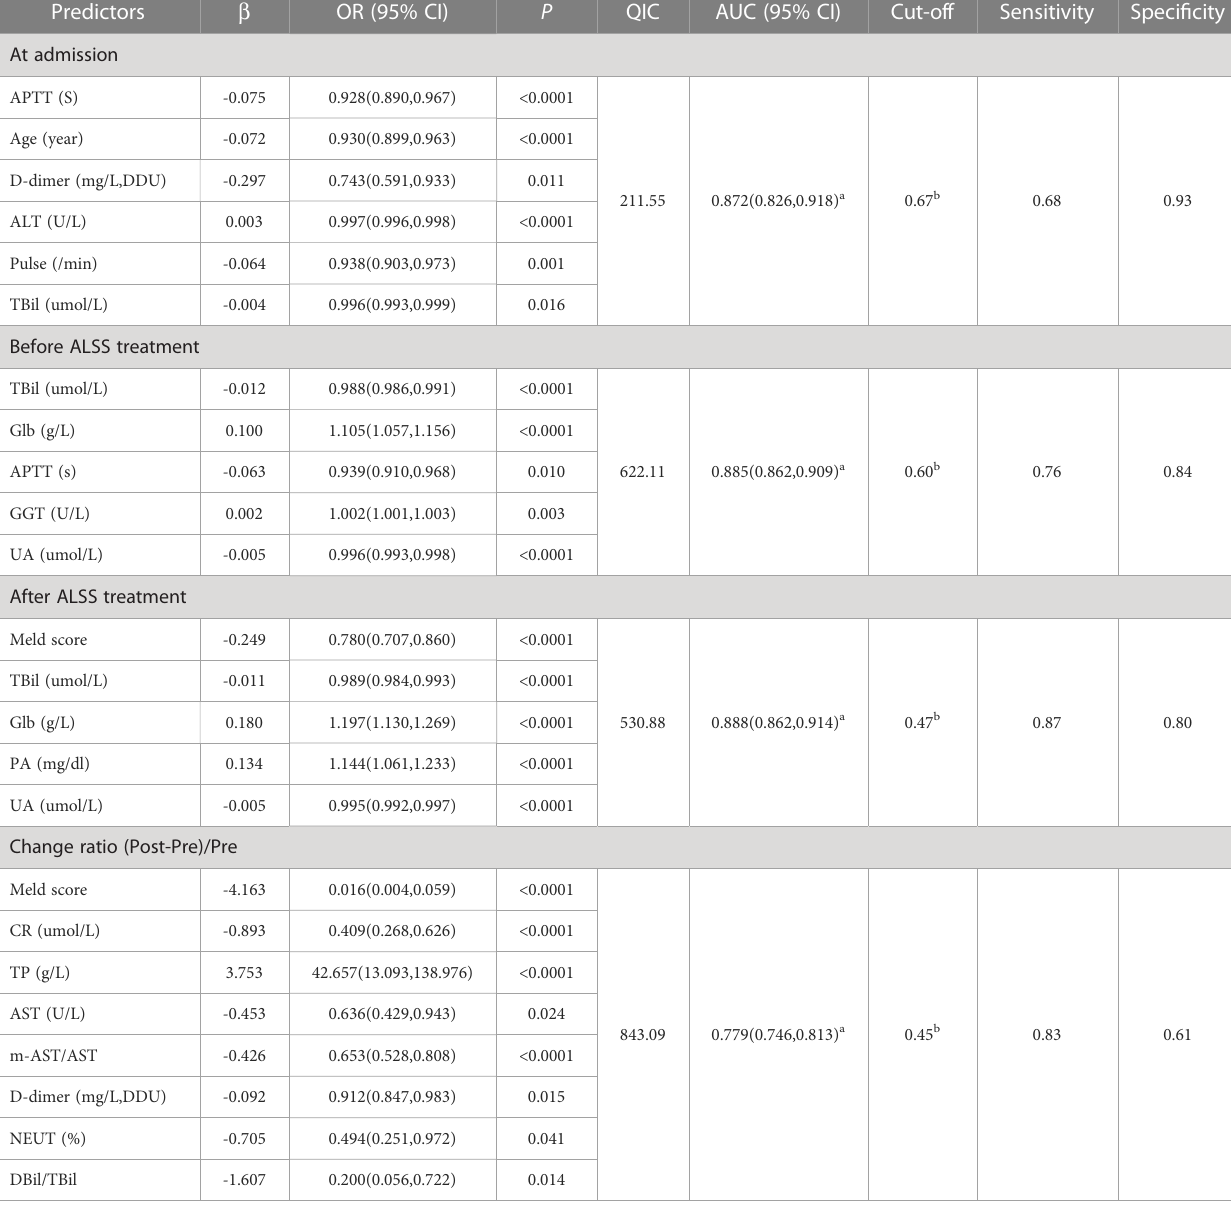
TABLE 2 Multivariate GEE model for the effect of sessions of ALSS therapy on prognosis of patients with HBV-ACLF.